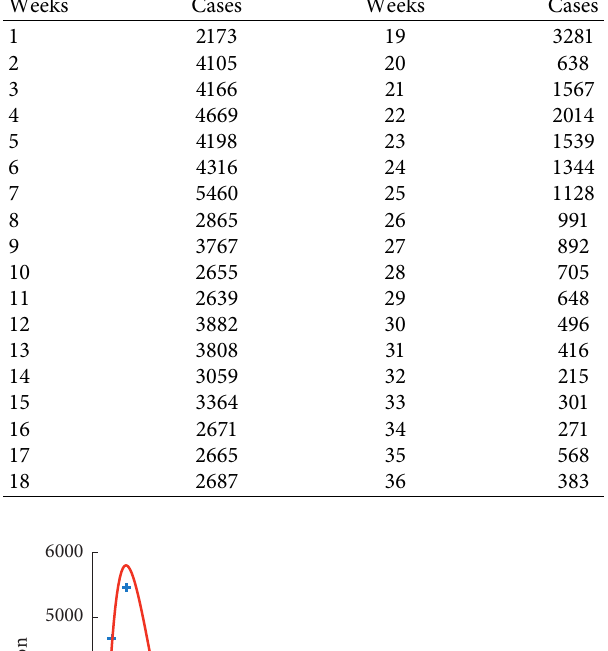
Table 5: The weekly reported data of Zika infection cases in Colombia from 1 to 36 weeks of 2016 provided by the National Institute of Health SIVIGILA, which are also used in [23].